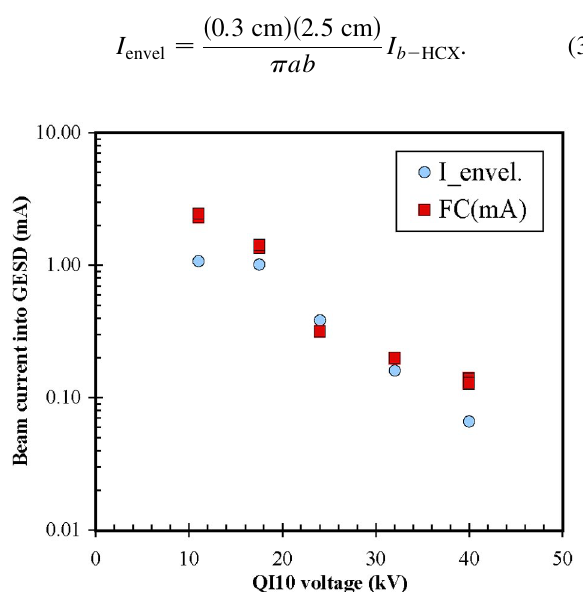
FIG. 7. (Color) Beam current into the GESD measured with the Faraday cup inside the GESD (red squares) and inferred from the total beam current times the entrance aperture area divided by the area that the beam is predicted to expand to at the GESD (blue circles) as the voltage on the final electrostatic quadru- pole QI10 is